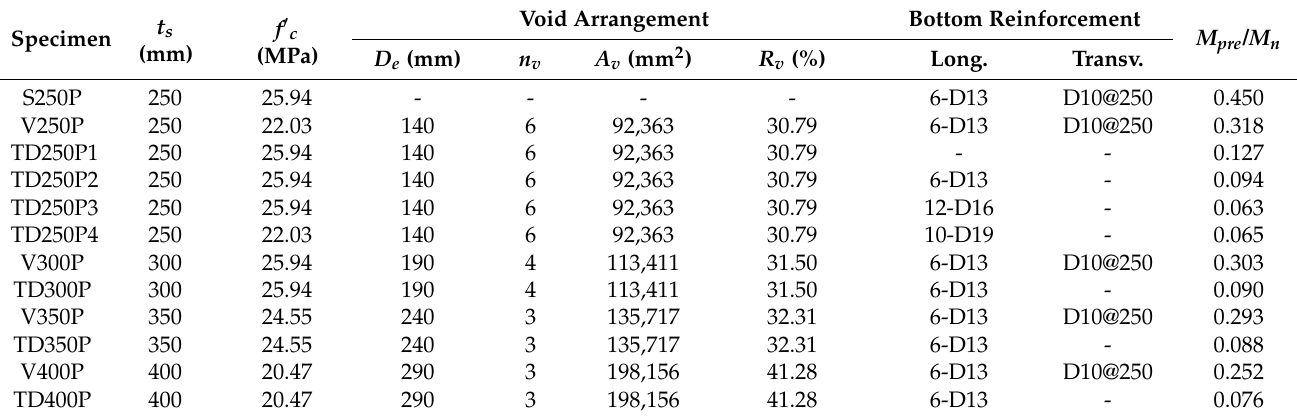
Table 1. List of tested slab specimens under consideration.